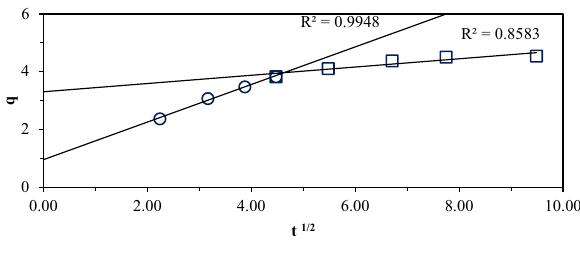
Fig. 16 Plot for q versus t ½ consisting of multiple straight line for MR sorption onto SCTJF at temperature 303 K